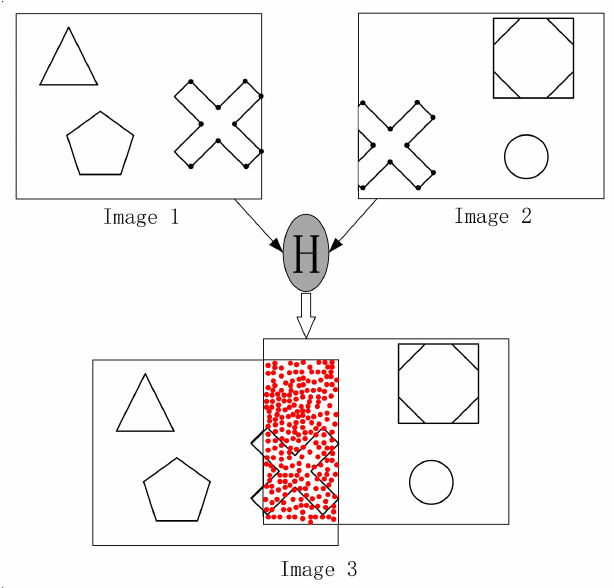
Figure 1. Image registration. The dark spots at the same position on image 1 and image 2 are a pair of known matching points. We can use them to calculate the homography matrix H and then use H to gain image